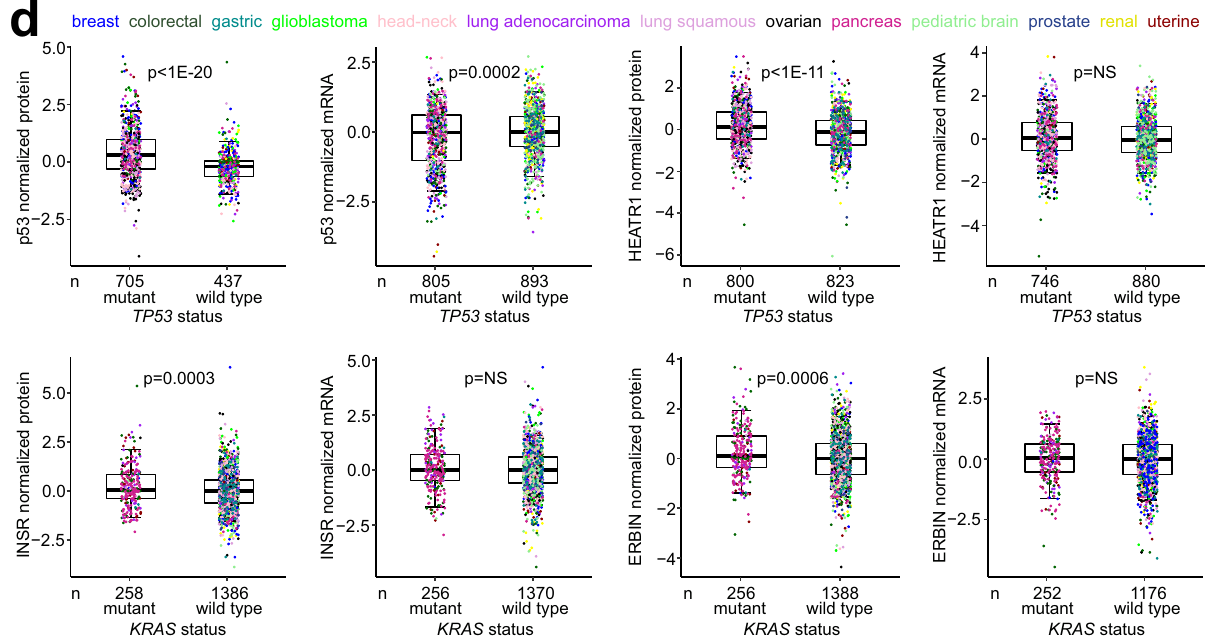
Fig. 8 Proteomic and transcriptomic signatures associated with somatic mutation of TP53 or KRAS . a Differential expression heat maps of top total protein features correlated with small somatic mutation of TP53 (left, FDR < 10%) or with somatic hotspot mutation of KRAS (right, FDR < 10%) across all cancers studied ( n = 1440 tumors with protein and mutation data). SD standard deviation from the median. b Across TP53 and KRAS comparisons, heat map representation of differential statistics for protein and mRNA features correlated with mutation status (FDR < 10%). c Taking the genes from b , gene sets were de fi ned according to mutation association by protein versus mRNA (using p < 0.05 with the 5414 genes signi fi cant with FDR < 10% for any comparison). For each mutation signature analysis, genes signi fi cant (up in mutant versus down) for both protein and mRNA or for one molecular level but not the other were assessed for represented categories by GO, with selected enriched categories represented here. p values by one-sided Fisher ’ s exact test. d For selected genes ( TP53 , HEATR1 , INSR , ERBIN ), box plots compare TP53 or KRAS mutant versus wild-type tumors for relative levels of protein versus mRNA, as indicated. p values by t -test. Box plots represent 5% (lower whisker), 25% (lower box), 50% (median), 75% (upper box), and 95% (upper whisker). n = biologically independent